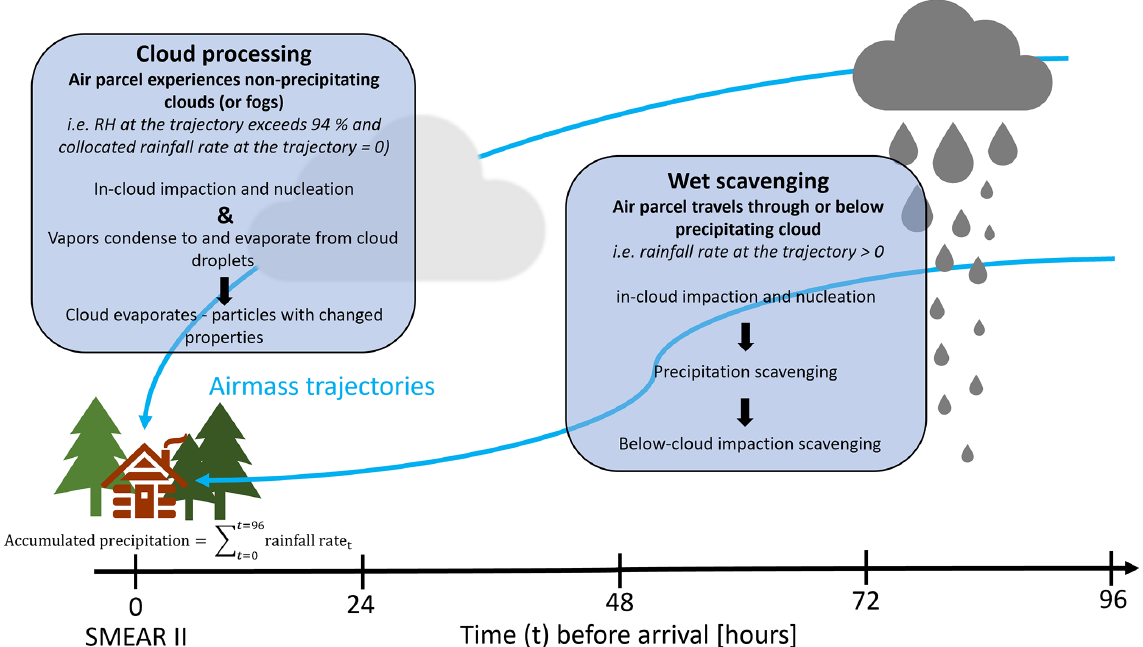
Figure 2. Schematic visualising the wet processes along air mass trajectories in the Lagrangian framework. Travelling particles experience different conditions en-route, thus alternating the observed particle concentrations (through scavenging) and composition (through cloud processing) at the SMEAR